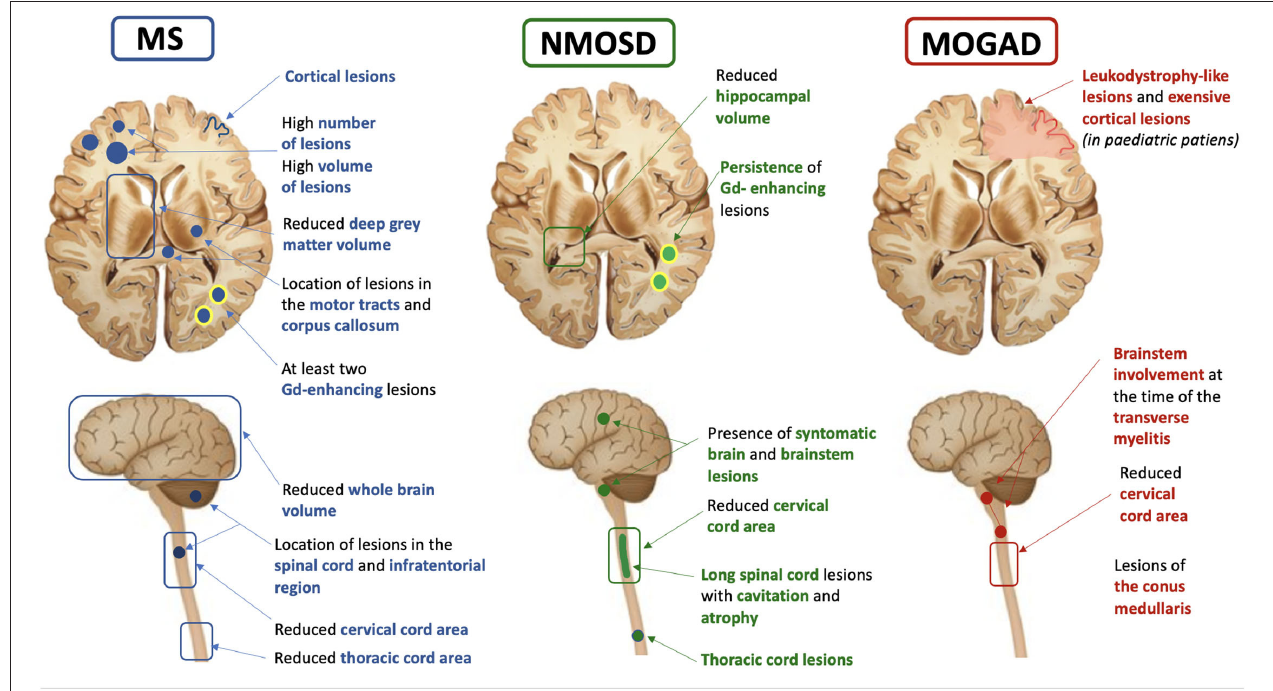
FIGURE 1 | Summary of the most common, clinically available MRI prognostic features in multiple sclerosis (MS), neuromyelitis optica spectrum disorder (NMOSD), and myelin oligodendrocyte antibody disease (MOGAD).